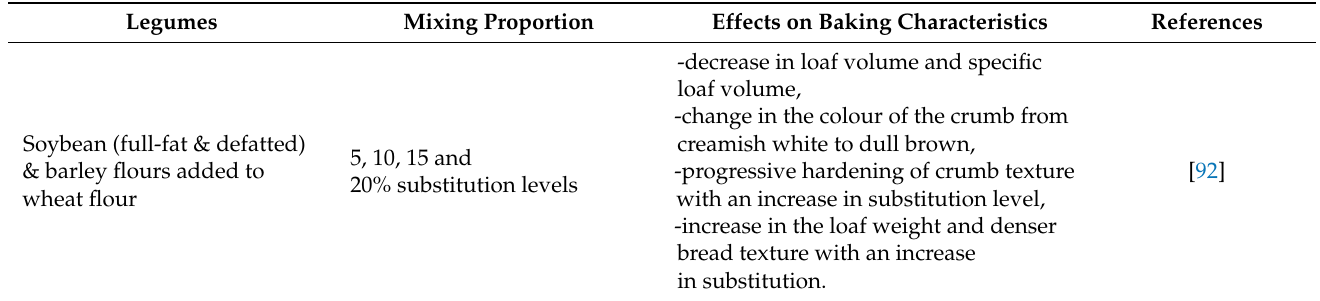
Table 4. Impacts of protein substitution on baking characteristics of bread. Legumes Mixing Proportion Effects on Baking